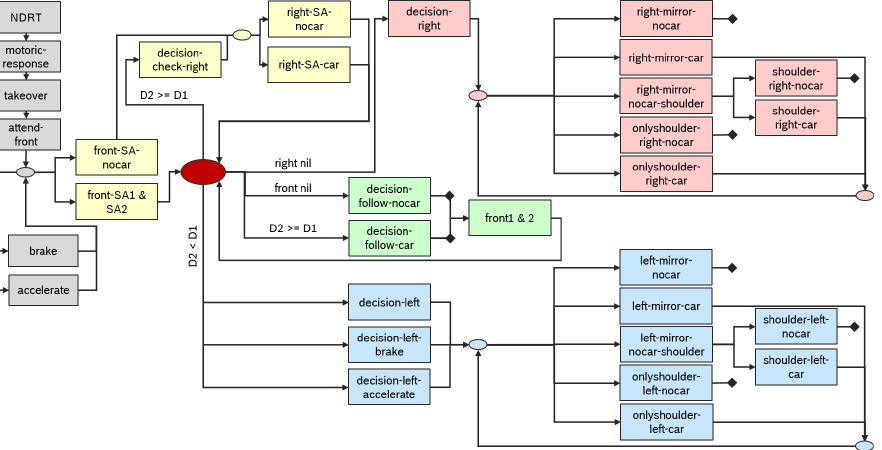
Figure 4. Structure of the Cognitive Model. Boxes with productions that represent the procedural system. Arrows show possible steps in the process. Ovals mark process points, where the goal in the goal buffer is changed. Colors mark different steps in the process to build up situation awareness (SA; gray = takeover and first motoric reactions, yellow = building of first SA to base a decision on, blue = lane change right, green = following, red = lane change left; D = distance; source: own